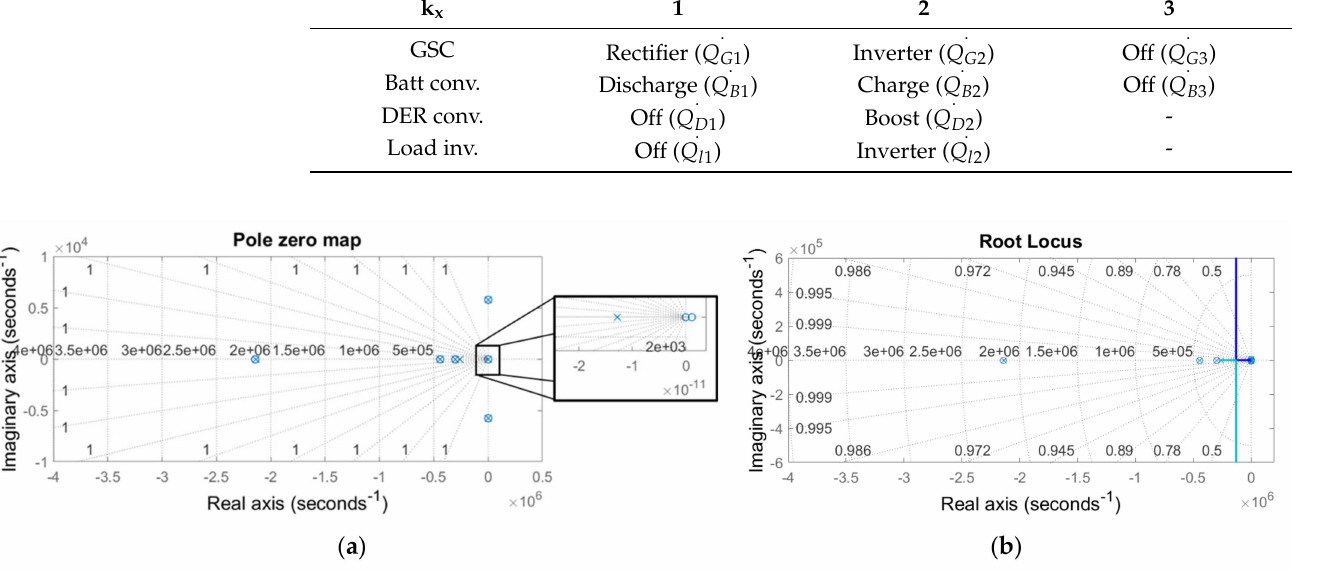
Figure 4. ( a ) Pole zero map for Mode 1 for MPEI. ( b ) Root locus of State 1 for